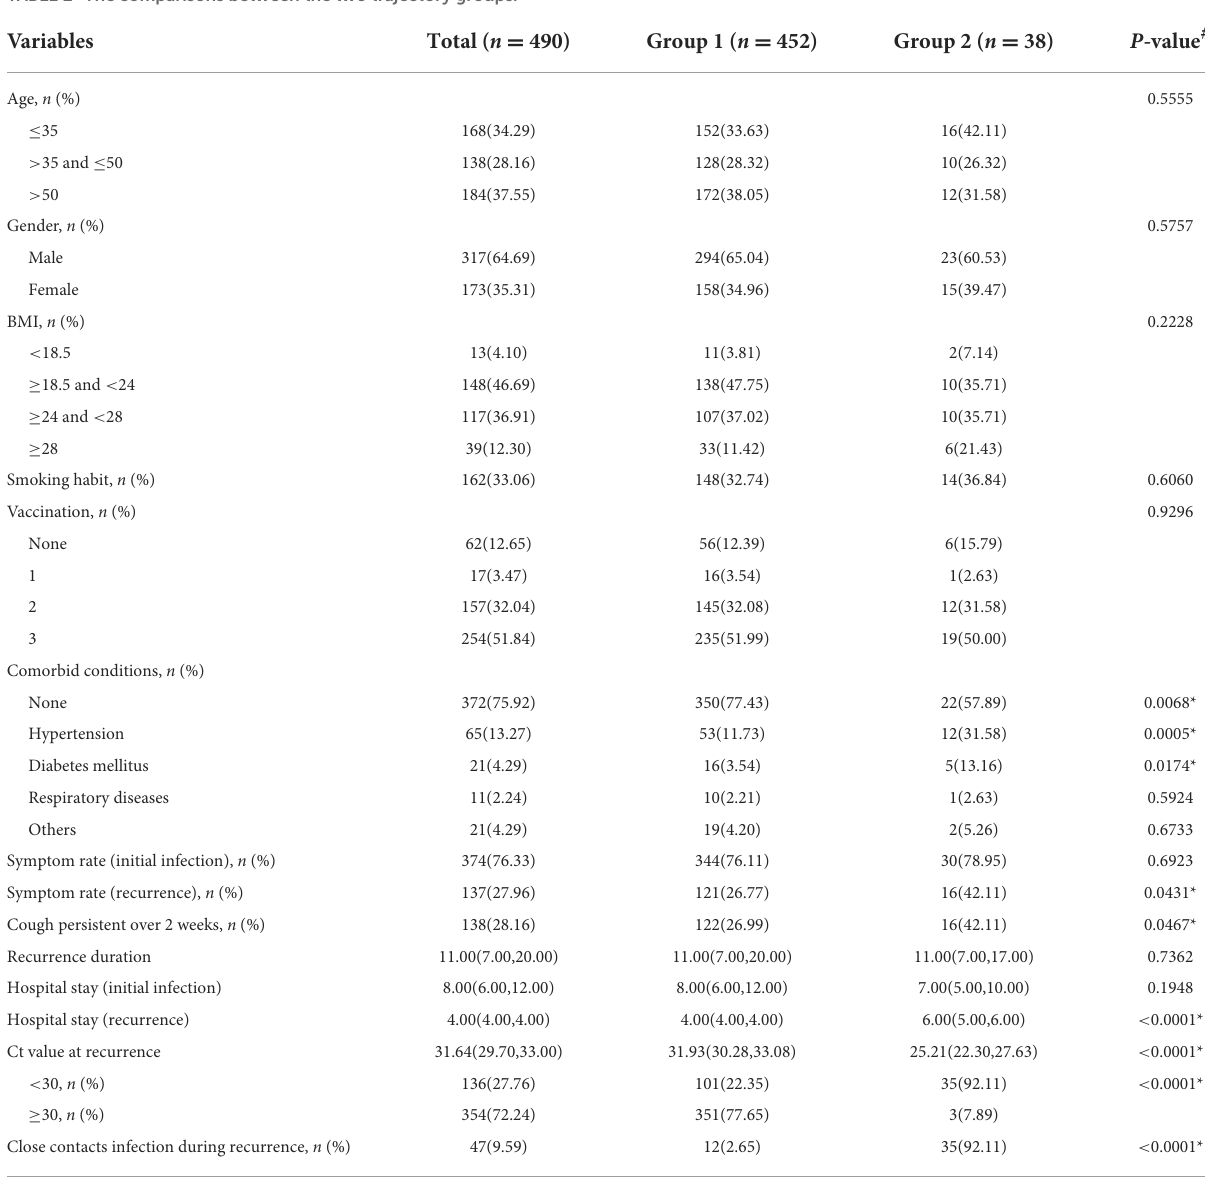
TABLE 2 The comparisons between the two trajectory